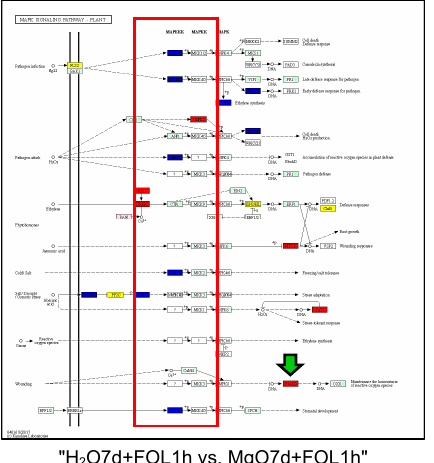
Figure 3. KEGG enrichment pathway: MAPK signaling pathway-plant. The red and blue boxes represent genes that are upregulated and downregulated, respectively. The yellow boxes represent genes that are both upregulated and downregulated. The red frames indicate MAPKKK, MAKK, and MAPK genes, from left to right. The blue frames indicate pathways with reduced expression. The red arrows indicate the upregulated OXI1 gene. The green arrows show the upregulated RbohD gene. Black solid arrows indicate stimulation/activation. Black dashed arrows indicate indirect effect.